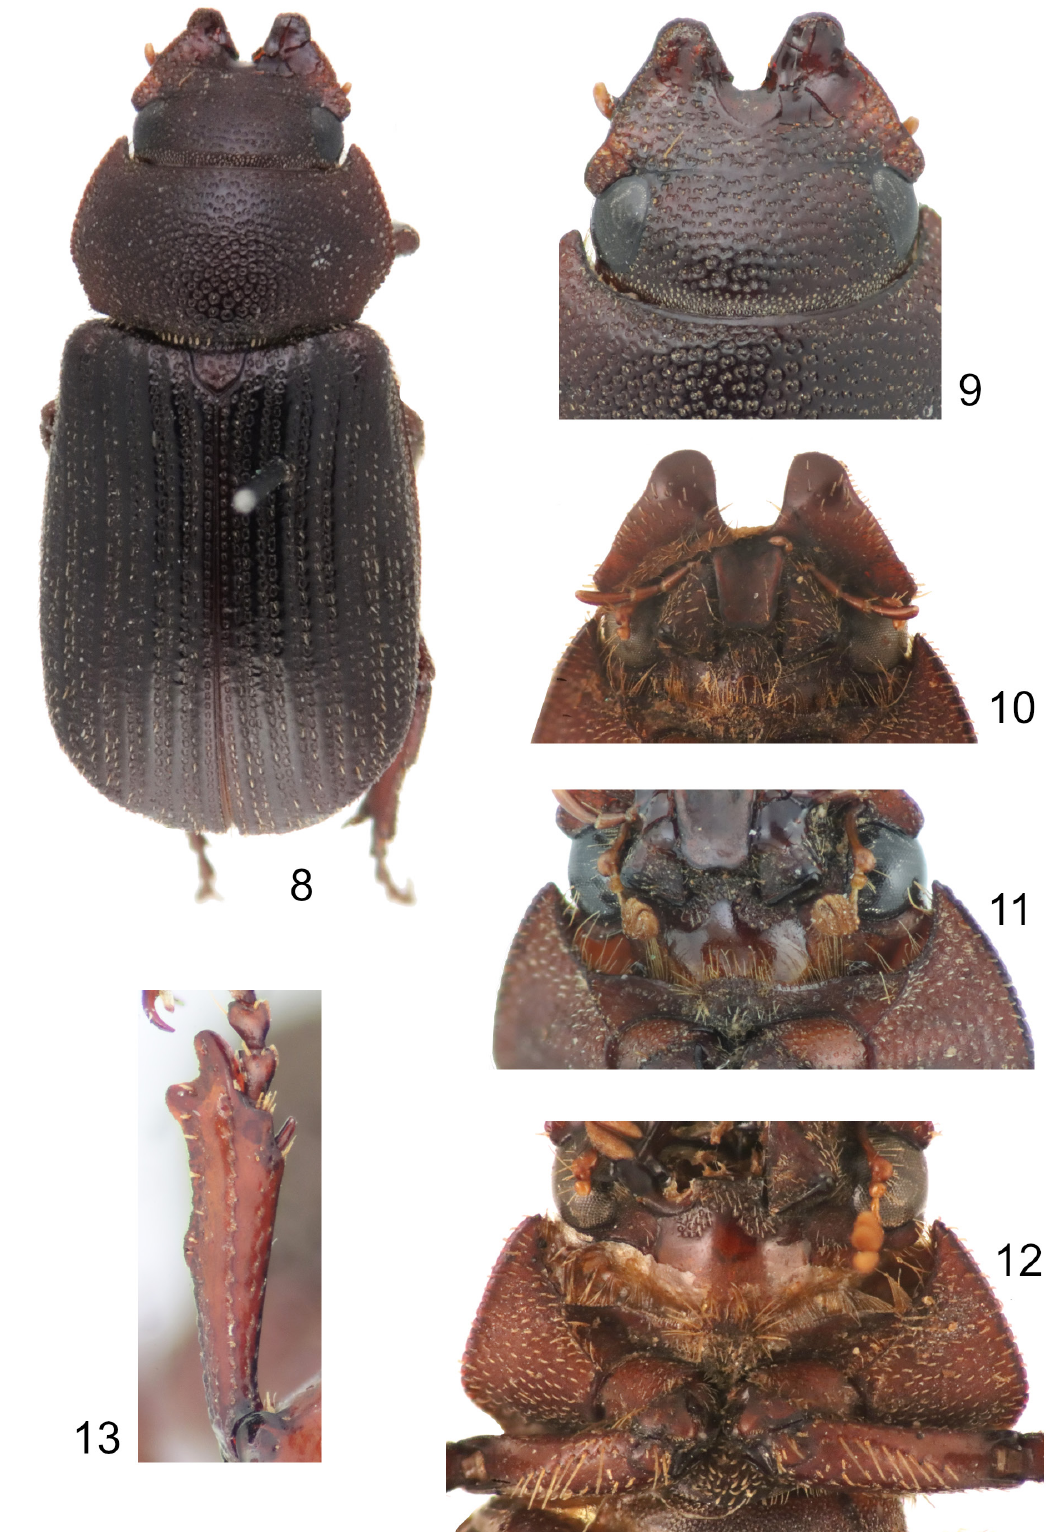
Figs 8–13. Maechidius divergens (Waterhouse, 1875) comb. nov., ♂ (BMNH). 8 . Habitus, dorsal view. 9 . Head, dorsal view. 10 . Same, ventral view. 11 . Head, ventral view and antennal pockets. 12 . Prosternum and pronotal hypomera, ventral view. 13 . Left protibia. Not to